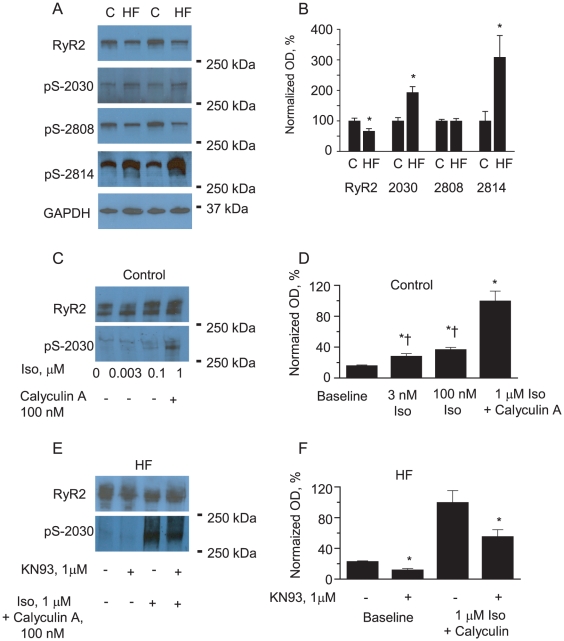
Enhanced phosphorylation of RyR2 at sites S-2814 and S-2030 in HF.A, B. Representative Western blots (A) and pooled data (B) for normalized RyR2 phosphorylation at sites - S-2030 and S-2808 and S-2814 to total RyR2 content measured in gels run in parallel. Levels of RyR2s in HF and control cells were compared using GAPDH as loading control. *p<0.05, n = 8. C.D, Representative Western blots (C) and pooled data (D) for β-adrenergic agonist Isoproterenol dose-dependence of S-2030. Signals obtained with anti pS-2030 ab were normalized to the levels of RyR2s assessed in gels run in parallel and normalized to maximum level of phosphorylation achieved by 30 min incubation of myocytes isolated from normal hearts with PP1 and PP2A inhibitor Calyculin A (100 nM) and exposed to 1 µM Iso for 3 min. *†,p<0.05 vs baseline and Iso+Calyculin respectively, n = 6. E,F. Representative Western blots and pooled data illustrating sensitivity of S-2030 to phosphorylation by CaMKII in myocytes isolated from failing hearts. Incubation with CaMKII inhibitor KN93 (1 µM, 15 min) significantly reduced S-2030 phosphorylation at basal conditions and after myocytes treatment with Iso and Calyculin A. *p<0.05 vs no KN93, n = 4.